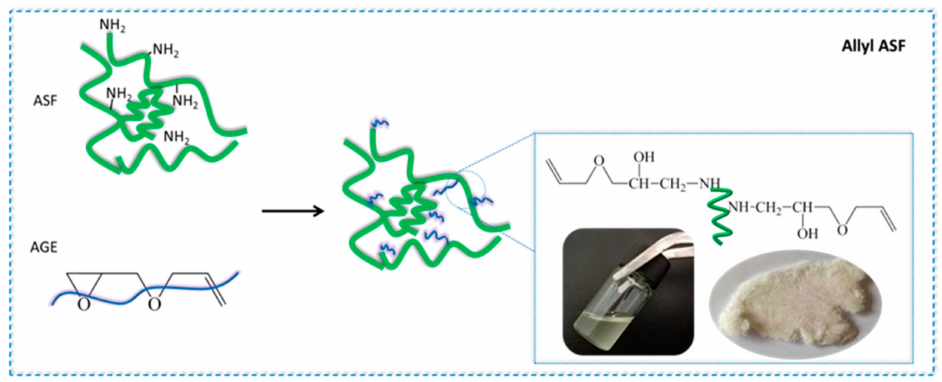
Figure 2. A schematic illustration of the synthesis of